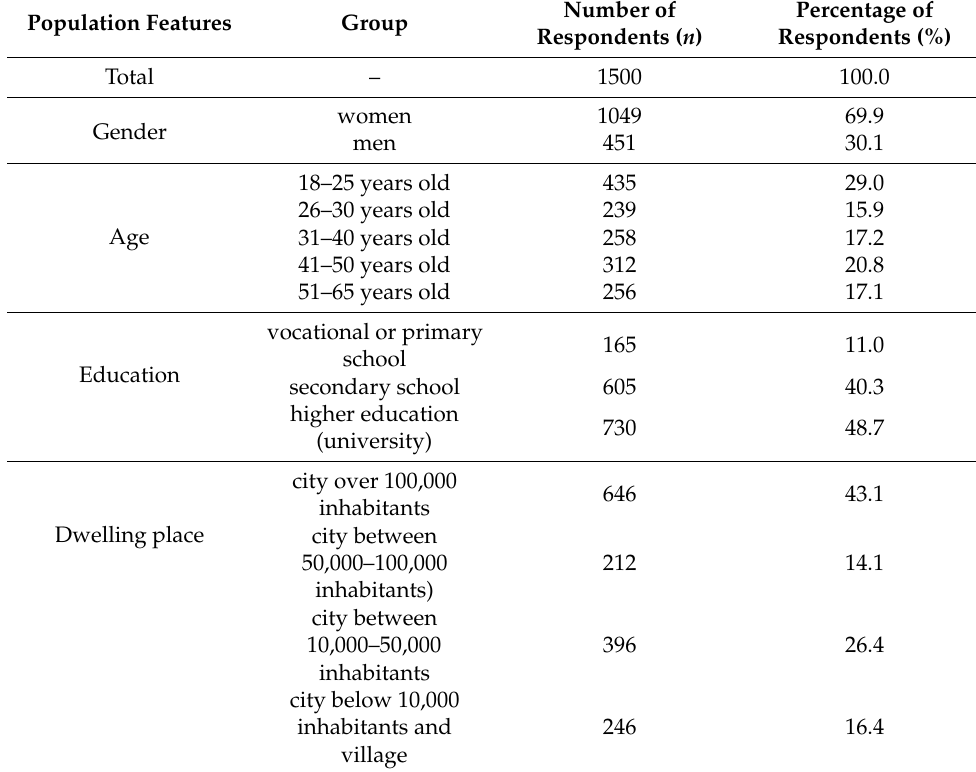
Table 2. Characteristics of the surveyed sample of respondents. Population